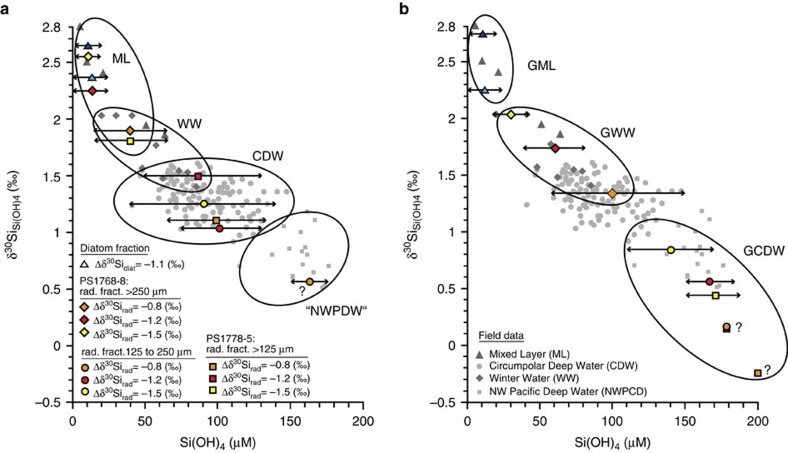
Reconstructed δ30SiSi(OH4) values and Si(OH)4 seawater concentrations compared with values in modern water masses.(a) Average Holocene and (b) glacial-time δ30SiSi(OH4) values and Si(OH)4 concentrations in seawater reconstructed from δ30Sirad data and δ30Sidiat values in cores PS1768-8 and PS1778-5 compared with modern seawater δ30SiSi(OH4) values and Si(OH)4 concentrations in different water masses29 (Supplementary Table 4). The blue triangles indicate the δ30SiSi(OH4) values reconstructed from the δ30Sidiat data of the two cores by using a Δδ30Si offset of −1.1‰ (light blue: core PS1768-8 and dark blue: core PS1778-5), the coloured diamonds indicate the δ30SiSi(OH4) values reconstructed from the δ30Sirad data of the size fraction >250 μm in core PS1768-8, the coloured dots indicate the δ30SiSi(OH4) values reconstructed from the δ30Sirad data of the size fraction 125–250 μm in core PS1768-8 and the coloured squares indicate the δ30SiSi(OH4) values reconstructed from the δ30Sirad data of the size fraction >125 μm in core PS1778-5. The Δδ30Si offsets applied to the δ30Sirad data were −0.8‰ (orange), −1.2‰ (red) and −1.5‰ (yellow) (see Methods). The obtained δ30SiSi(OH)4 values were related to δ30SiSi(OH)4 values from water stations and to their ranges in Si(OH)4 concentrations202829. The modern δ30Si values and Si(OH)4 concentrations were measured on seawater samples from the mixed layer (ML; grey triangles)29, Winter Water (WW; grey diamonds)29, CDW (grey dots)2829 and Northwest Pacific Deep Water (‘NWPDW'; grey squares)20. The reconstructed glacial-time δ30SiSi(OH4) values and Si(OH)4 concentrations (b) may allow to discriminate Glacial Mixed Layer (GML), Glacial WW (GWW) and Glacial CDW (GCDW). Double-headed arrows display the range in Si(OH)4 concentrations that can be attributed to the reconstructed δ30SiSi(OH4) values. It is worth noting that δ30SiSi(OH4) estimations based on Δδ30Sirad of −0.8‰ may tend to overestimated Si(OH)4 concentrations.